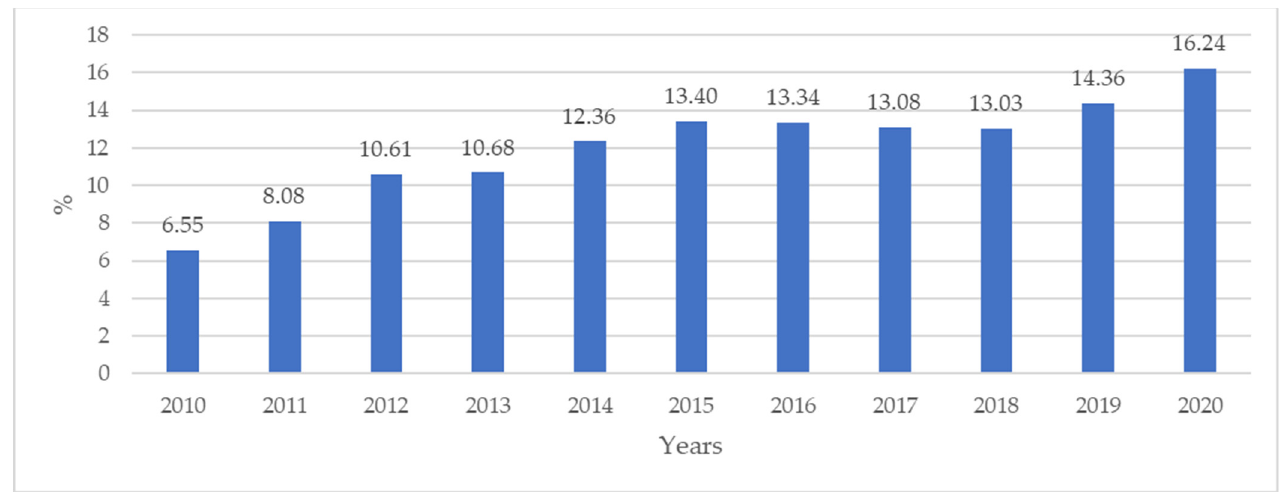
Figure 2. The share of electricity from renewable sources in the gross final consumption of energy in the electricity sector in Poland (%). Source: own elaborations based on [44].